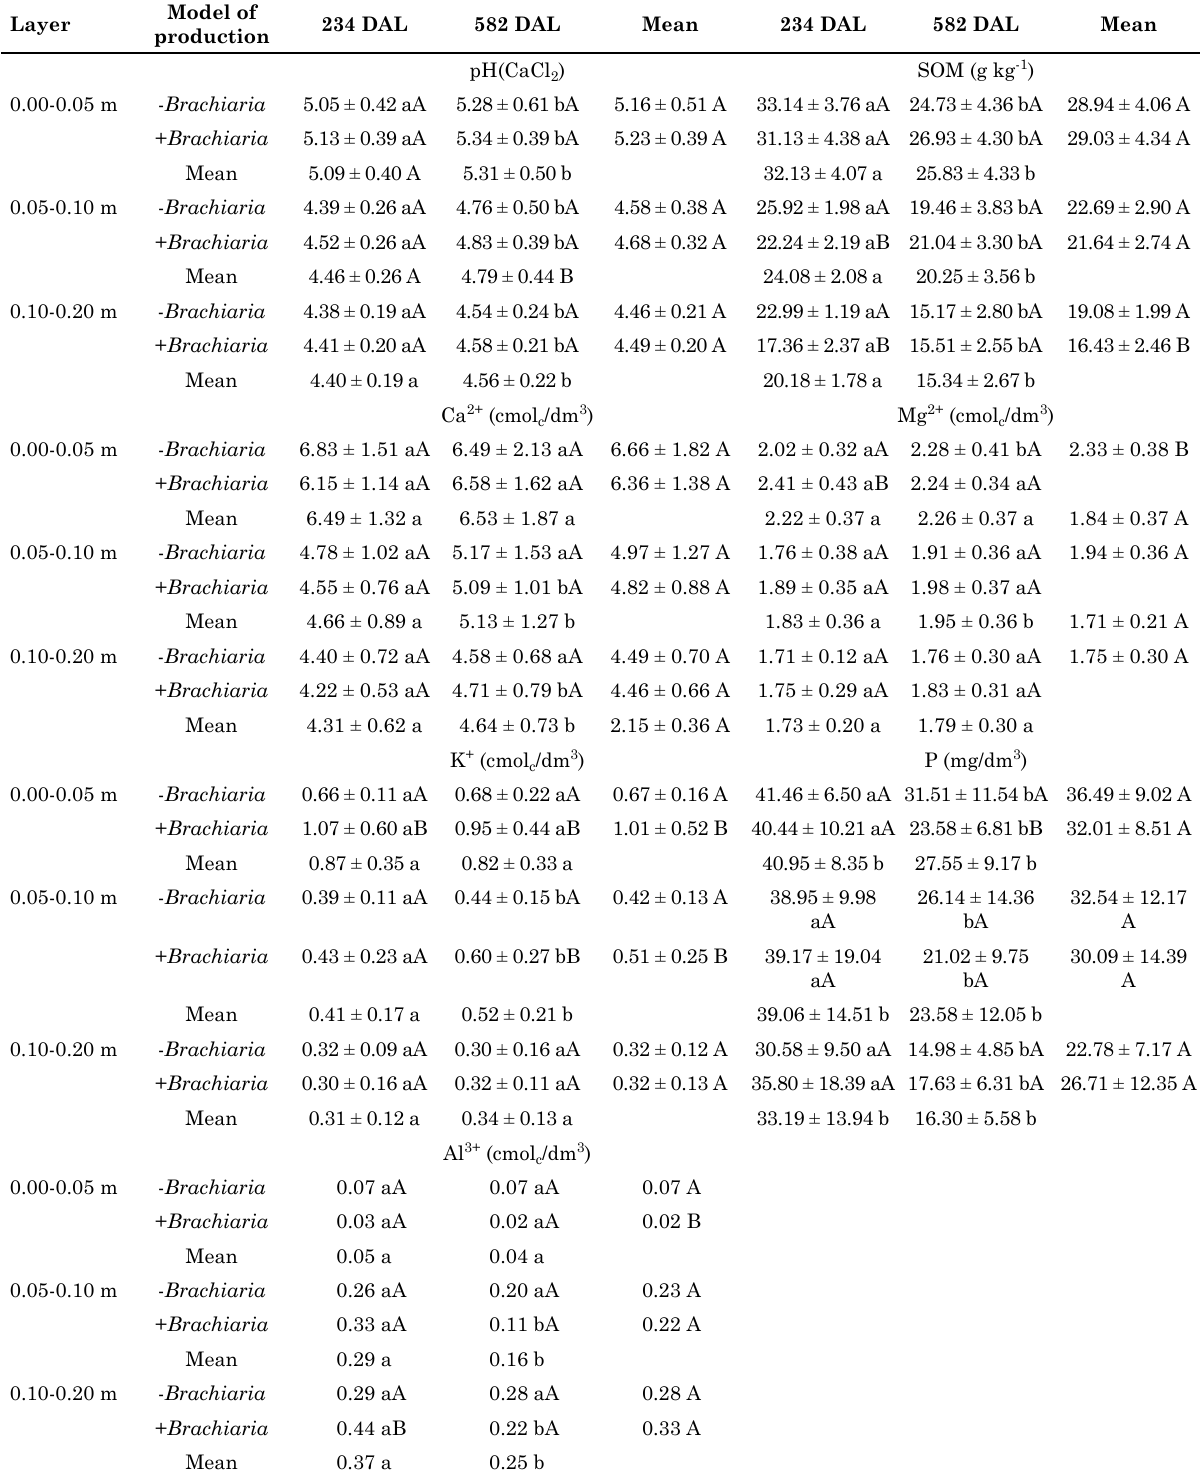
table 2. effects of the agricultural production system and time after liming (days after limming - dAL) on the variables tested at the 0.00-0.05, 0.05-0.10, and 0.10-0.20 m layers in a Latossolo Vermelho Eutroférrico